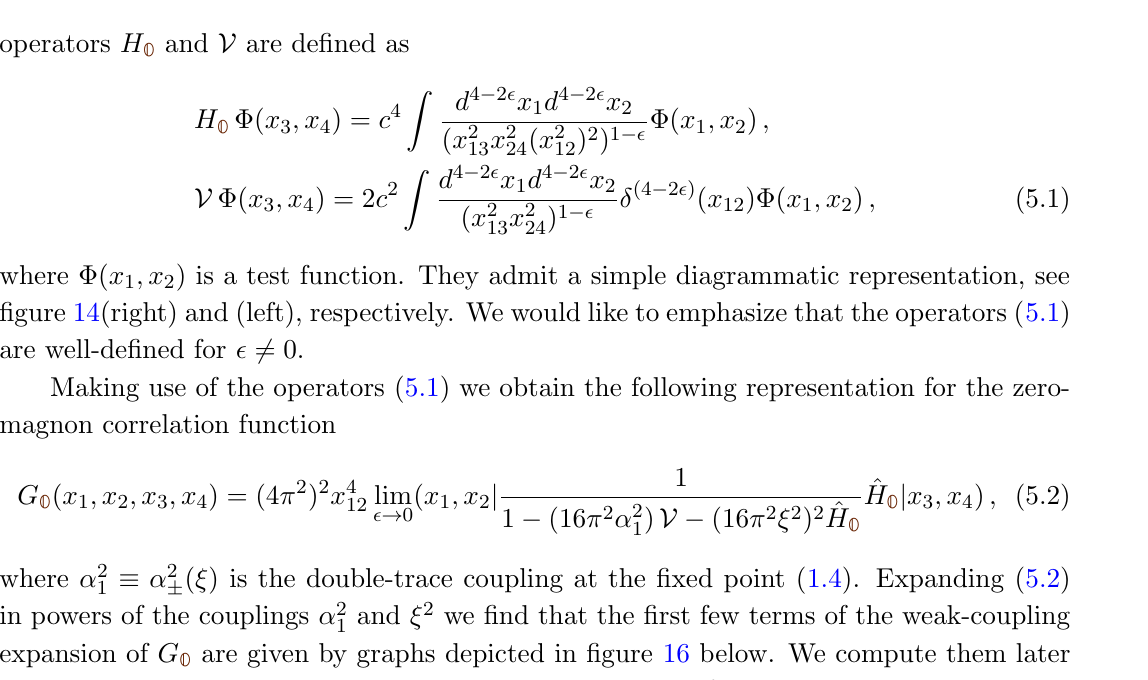
Figure 14 . Diagrammatic representation of the graph building operators V and H 0 de(cid:12)ned in (5.1). Dashed blue line denotes delta-function, black and dashed red lines stand for free scalar